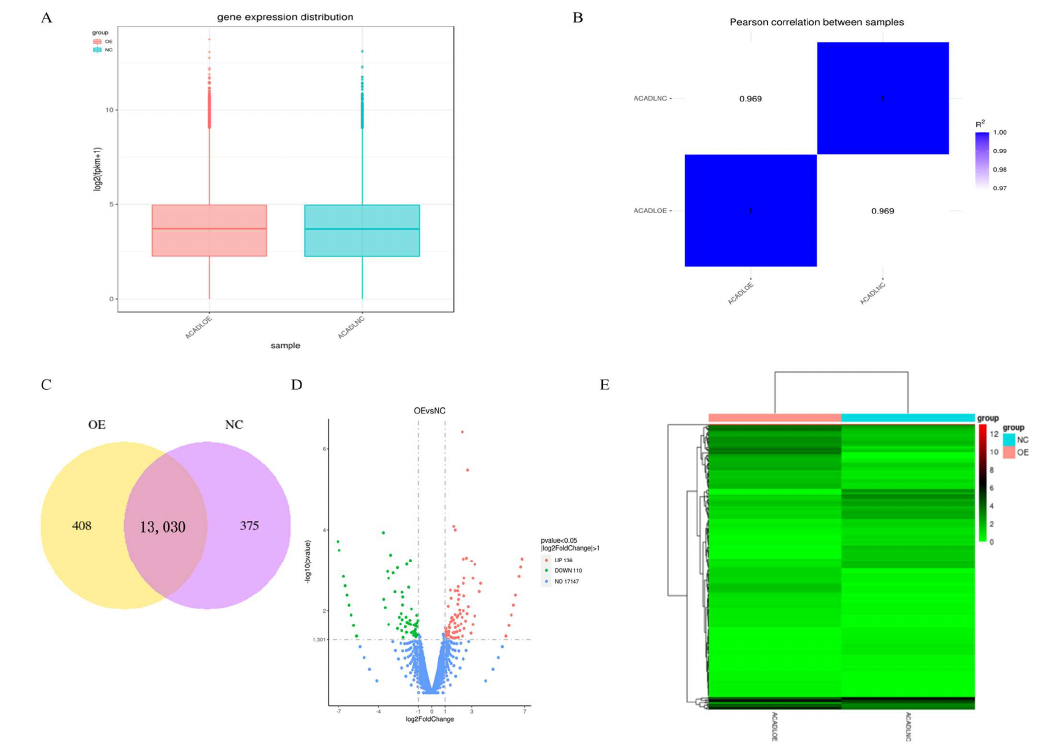
Figure 4. Gene expression analysis. ( A ) Distribution of gene expression. ( B ) Heat map of sample-to- sample correlation. The horizontal ordinate coordinates in the plot are the squares of the correlation coefficients for each sample. ( C ) Co-expression of Venn diagram. The number of genes uniquely expressed in each group, overlapping regions showing the number of genes co-expressed in two groups. ( D ) Differential gene volcano. The abscissa is the log 2 FoldChange value, the ordinate is log 10 padjust or -log 10 p-value, and the blue dotted line indicates the threshold line of the differential gene-screening criteria. ( E ) Heat map of differentially expressed gene clusters. Abscissa is the sample name, and the ordinate coordinate was the value of the FFPKM normalization of the differential gene, the redder the color, the higher the expression, the greener, and the lower the expression.